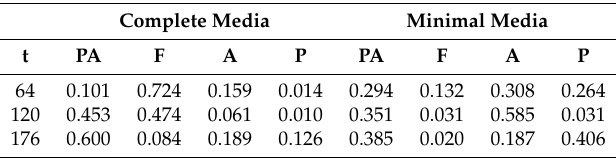
Table A3. Relative abundances of the four bacterial families at three intermediate time points (days 8, 15 and 22). The abundances were scaled from the experimental values (where more families were present) to add to